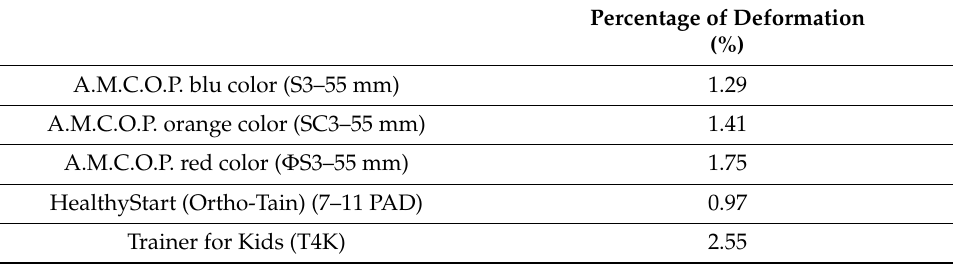
Table 2. Percentage of plastic deformation after 5